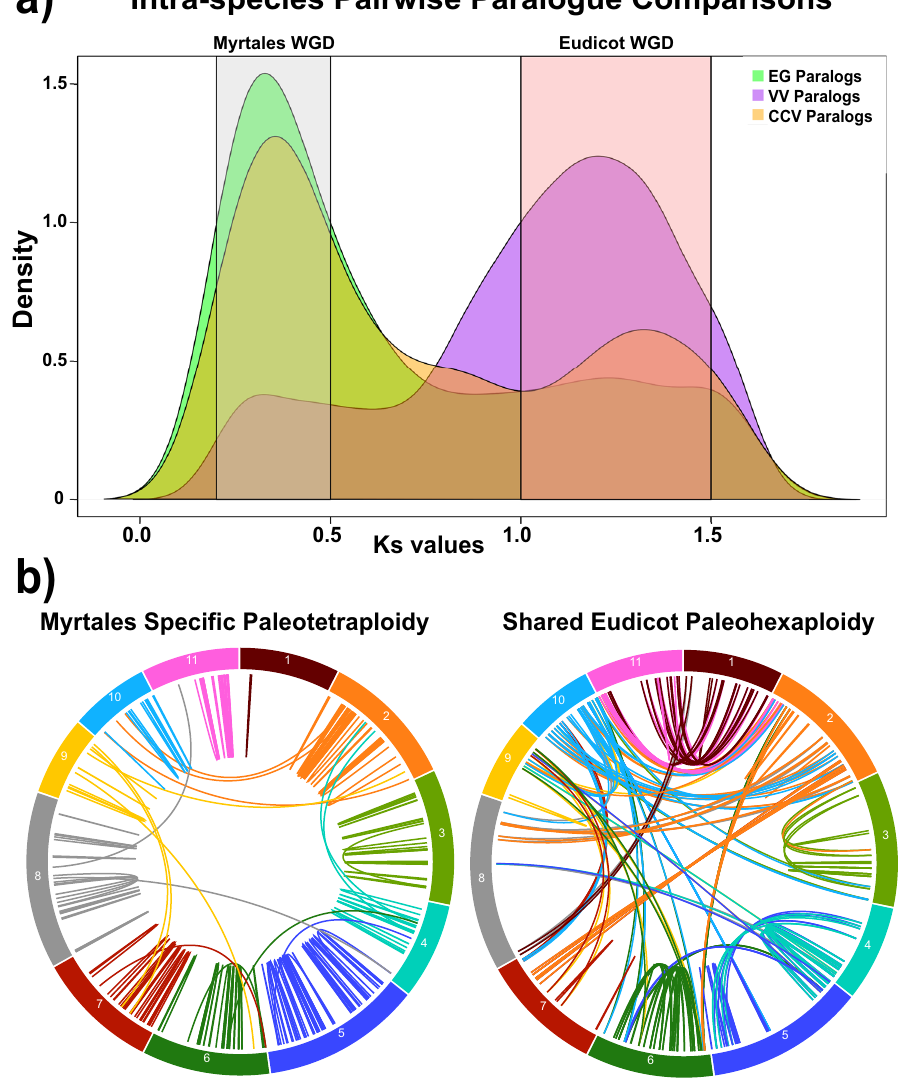
Fig. 4 Patterns of paralog retention in Corymbia resulting from whole-genome duplications (WGD). a Intra-species retained paralogous sequences from the shared eudicot and Myrtales speci fi c WGD events. Ks- synonymous mutation rate. Green distribution- Ks values among paralogous sequences within E. grandis . Yellow distribution- Ks values among paralogous sequences within C. c.variegata . Purple distribution- Ks values among paralogous sequences within Vitis vinifera . Gray box- paralogous sequences derived from the Myrtales WGD event. Pink Box- paralogous sequences derived from the Eudicot WGD event. CCV Corymbia citriodora subsp. variegata , EG Eucalyptus grandis , VV Vitis vinifera . b Corymbia chromosomal dispersal pattern of paralogs from the eudicot and Myrtales WGD event. Lines between chromosomes represent intra-speci fi c paralogous sequences that arose from each